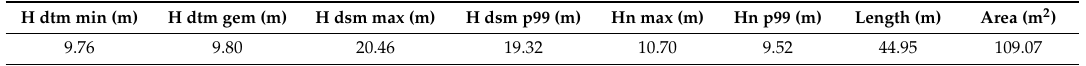
Table 4. Data of the Flanders Large-scale Reference 3D building archive.